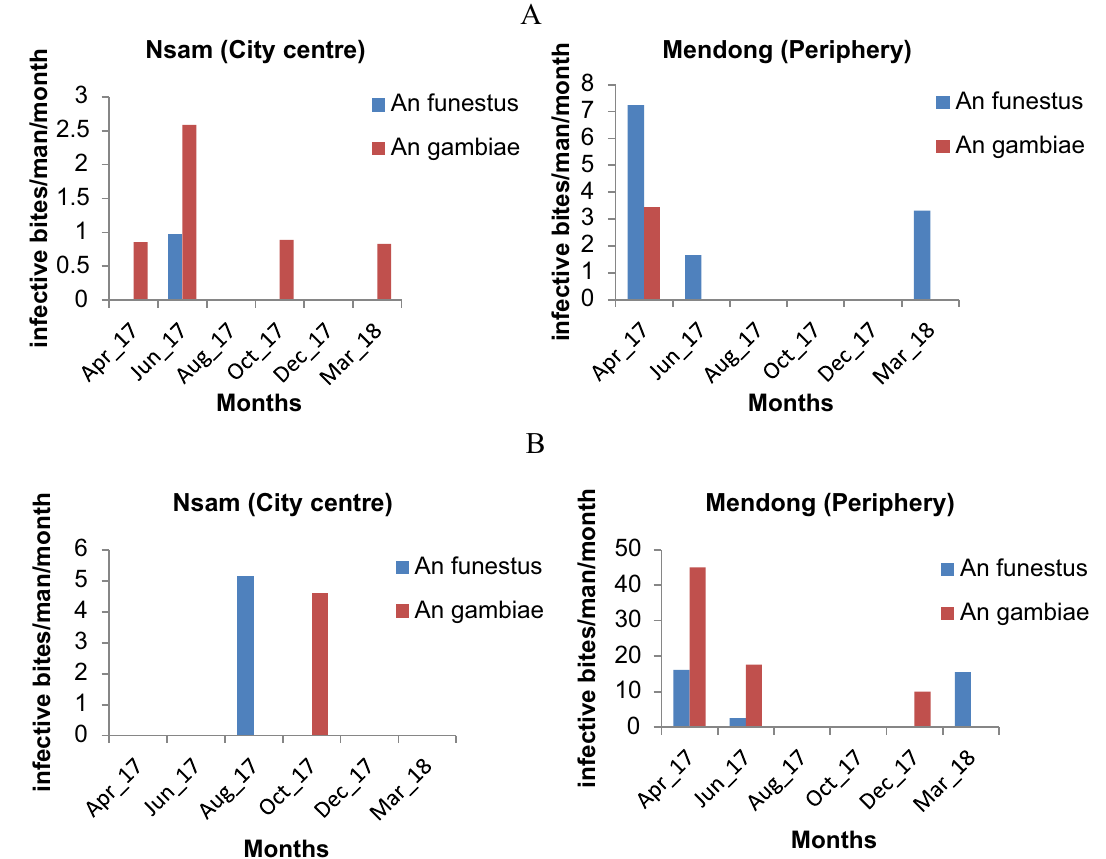
Figure 5. Malaria transmission pattern in Mendong and Nsam from April 2017 to March 2018: (A) monthly EIR using CDC light traps; (B) monthly variation of standard EIR using human landing catches.